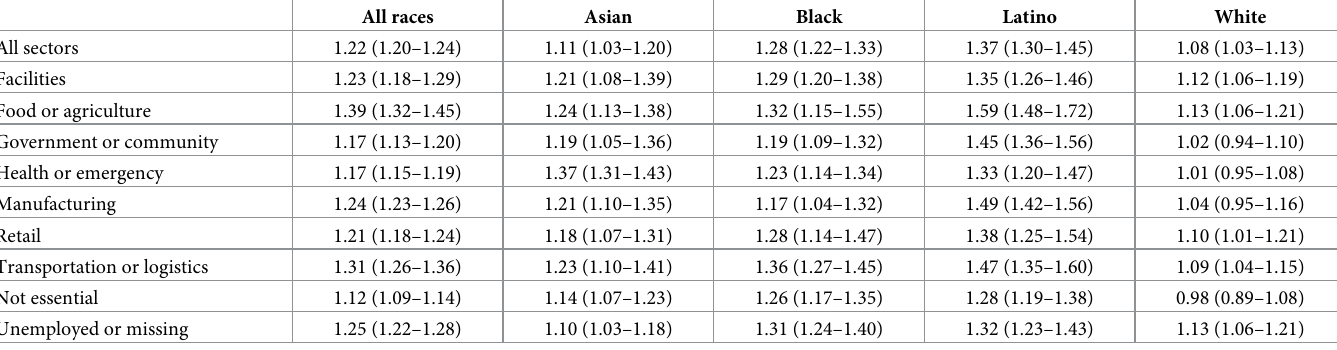
Table 2. Relative excess mortality among California residents 18–65 years of age, by occupational sector and race/ethnicity, March through November 2020.